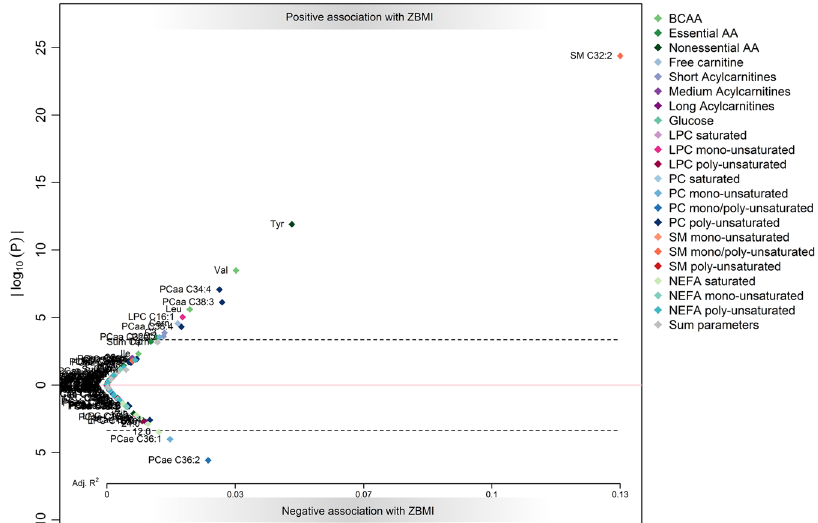
Figure 1. Results of the individual participant meta-analysis of the association of metabolites to BMI z-score. Log transformed p-values (y-axis) are plotted against adjusted R² (x-axis), with positive associations in the upper part (above 0) and negative associations in the lower part (below 0) of the figure. The dashed line indicates the Bonferroni-corrected significance level of 0.0004. Abbreviations: AA, amino acids; BCAA, branched-chain amino acids; LPC, lyso-phosphatidylcholine; NEFA, nonesterified fatty acid; PC, phosphatidylcholine; SM, sphingomyelin.